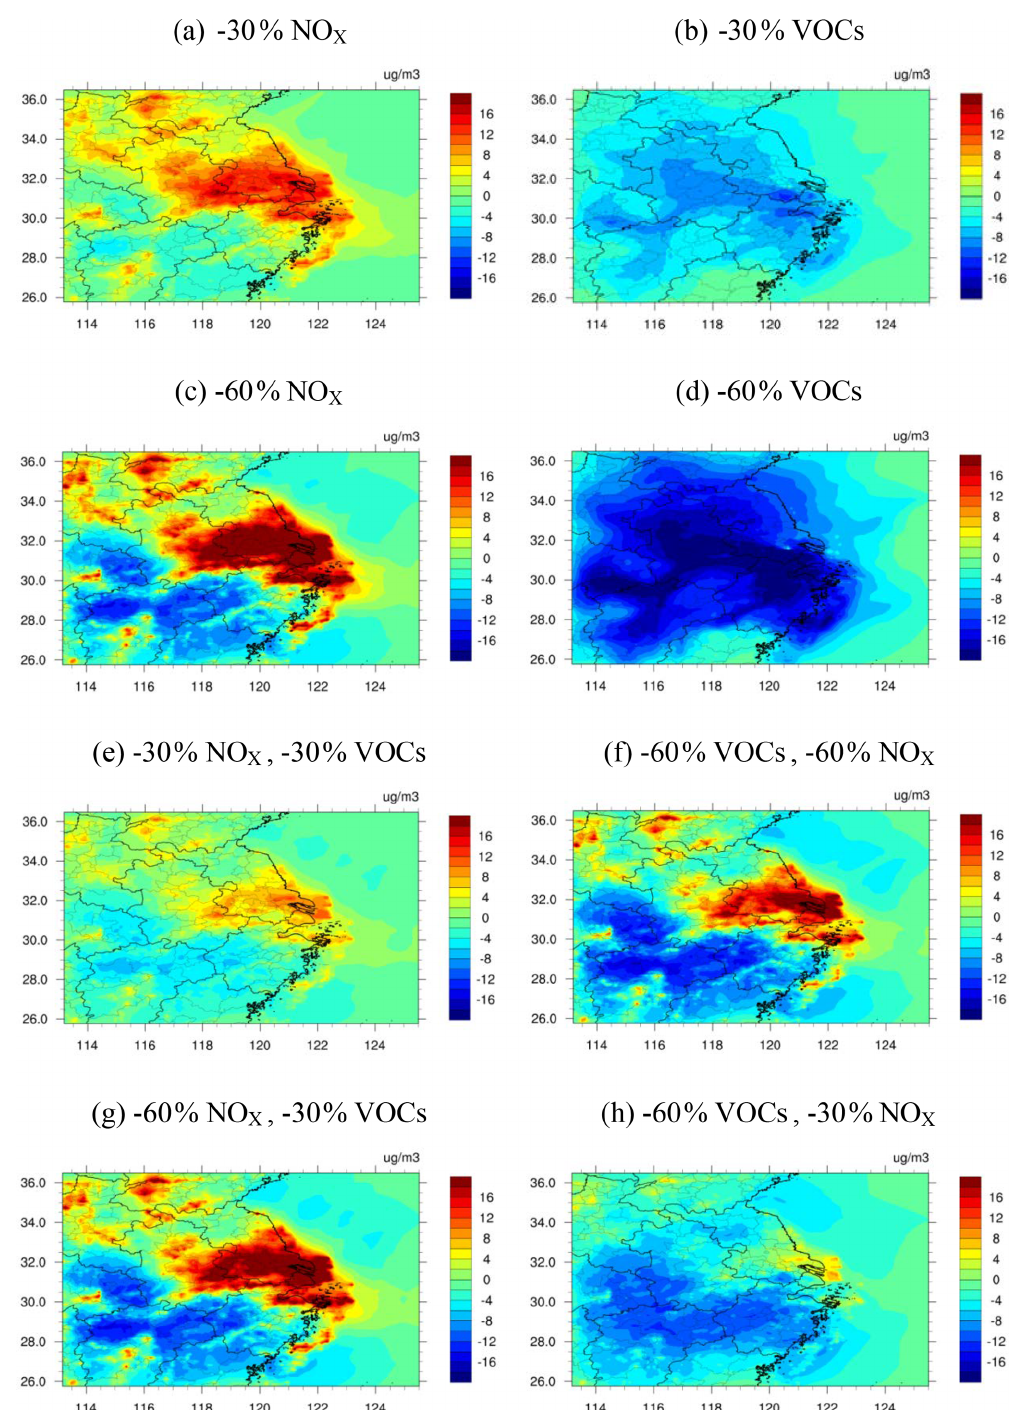
Figure 10. The spatial differences of monthly mean O 3 concentrations between the simulations based on the base case (top-down estimates) and sensitivity cases in April 2016 (sensitivity case minus base